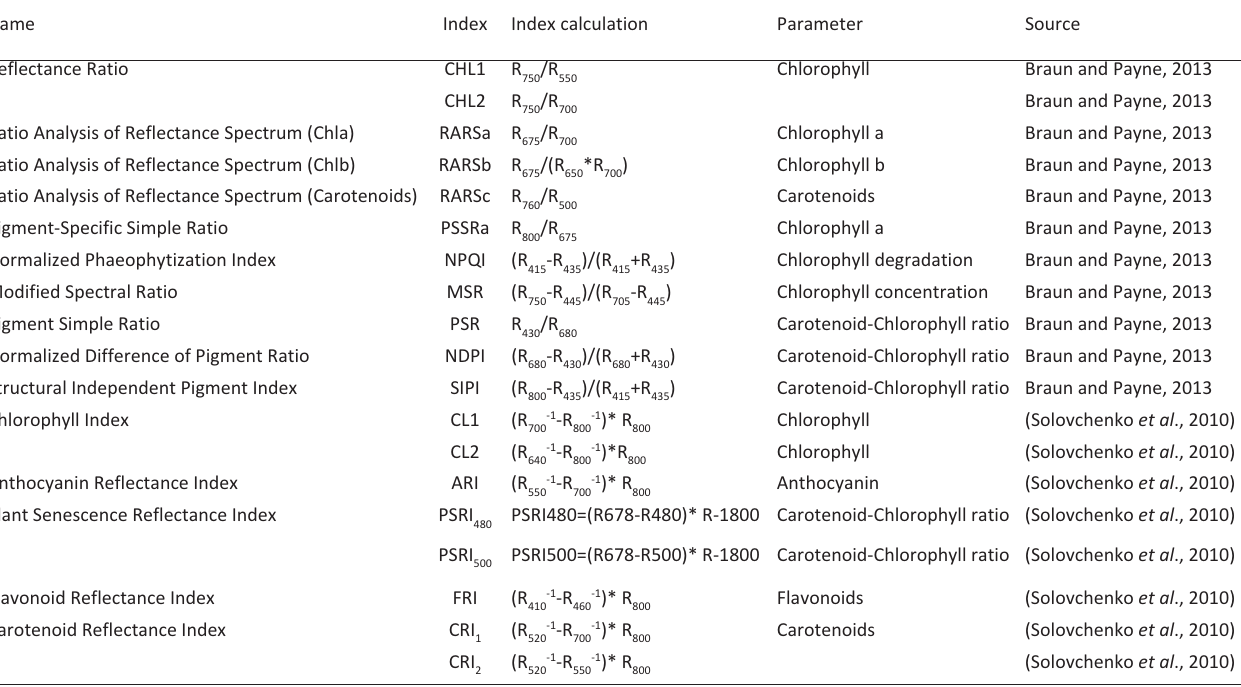
Table 1 ­ Indexes calculated by reflectance in the